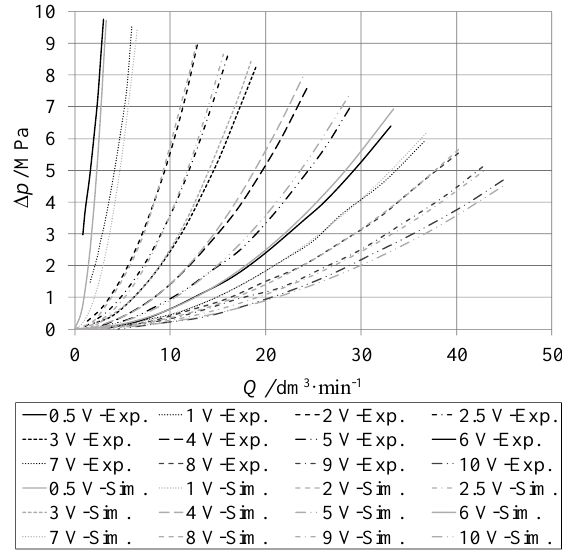
Fig. 7. Comparison of static ∆ p - Q characteristics For individual characteristics, the pressure drop Δ p increases with the increasing flow Q . Furthermore, at the same pressure drop Δ p the flow Q increases with the increasing control voltage U . By comparing the measurements and the simulations, it can be seen that the mathematical model (Sim.) corresponds to experimental measurement (Exp.).